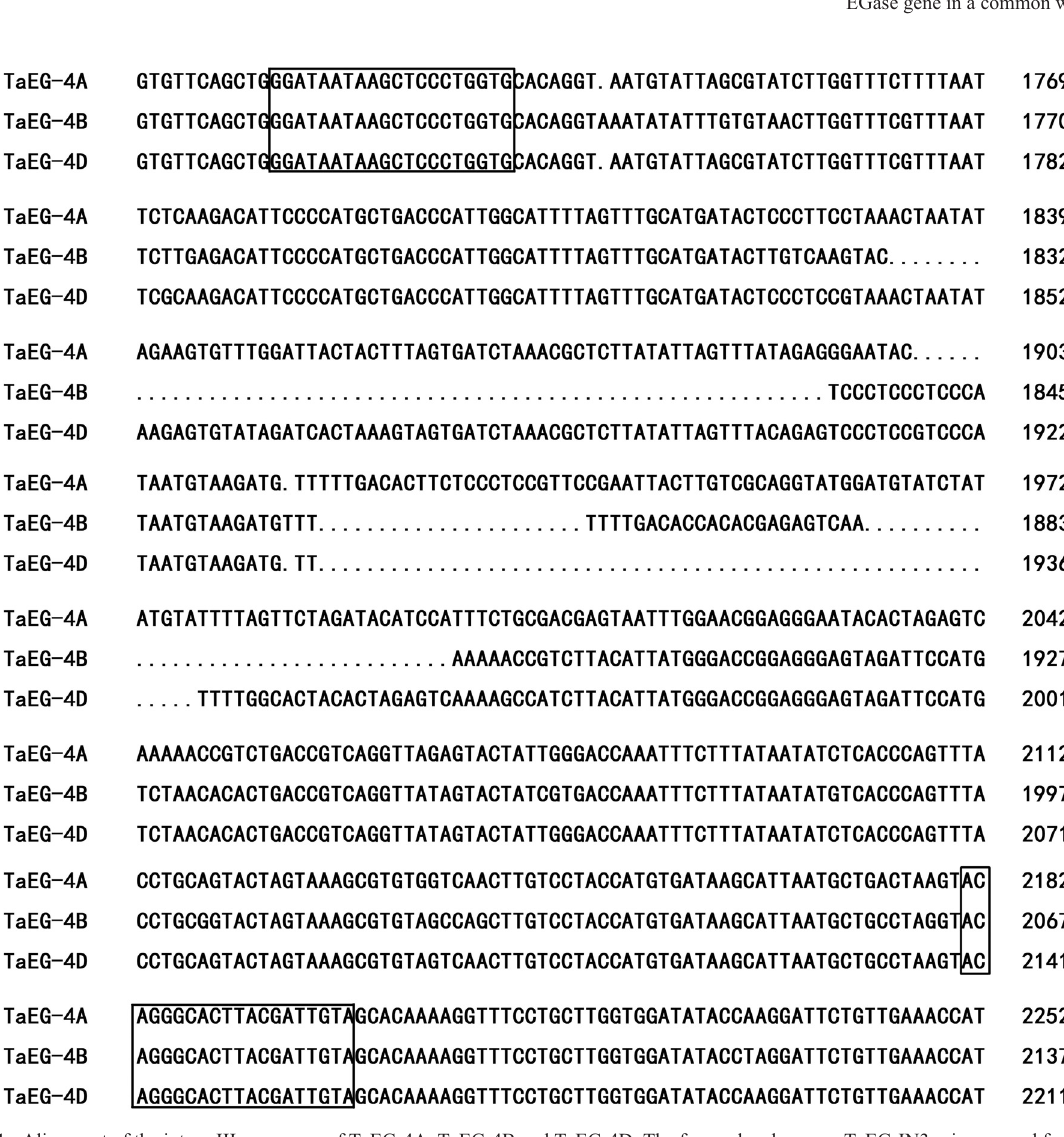
tabacum L. (NtCel2: AF362948, NtCel8: AF362949),